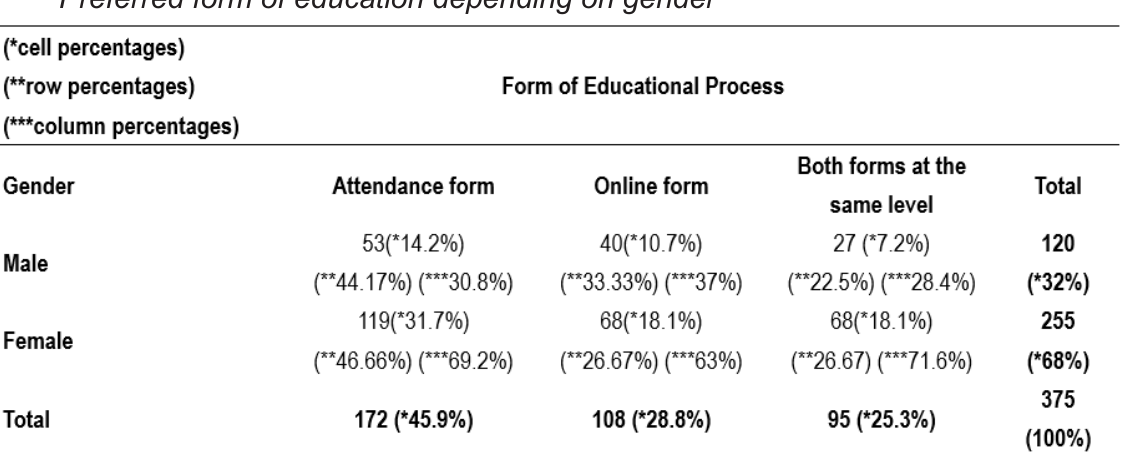
Preferred form of education depending on gender